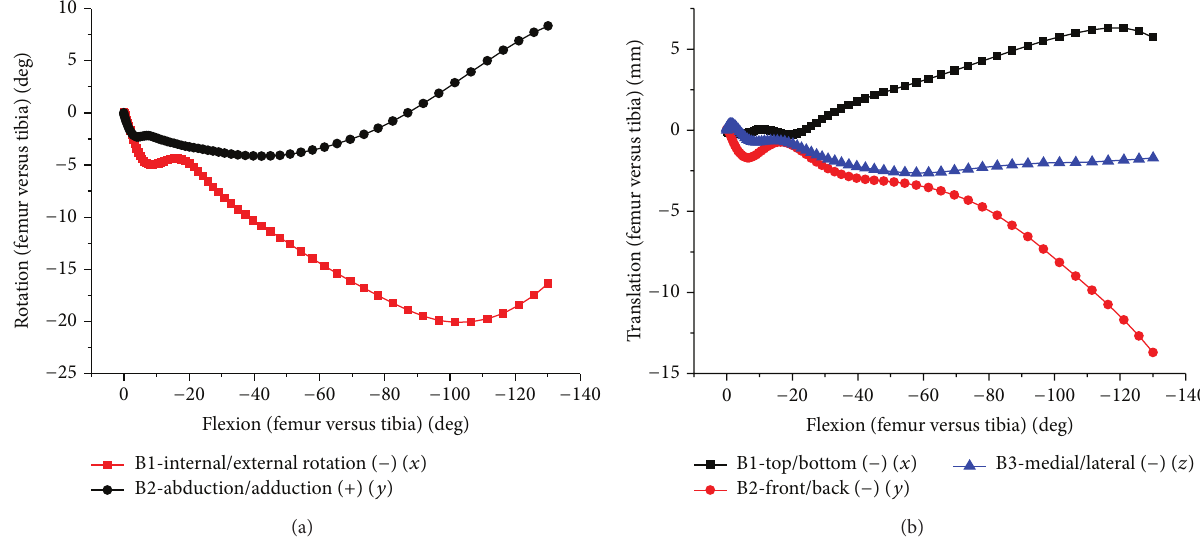
Figure 9: The relative movement of natural tibiofemoral joint. (a) Internal/external and abduction/adduction of tibiofemoral joint. (b) Translation of tibiofemoral